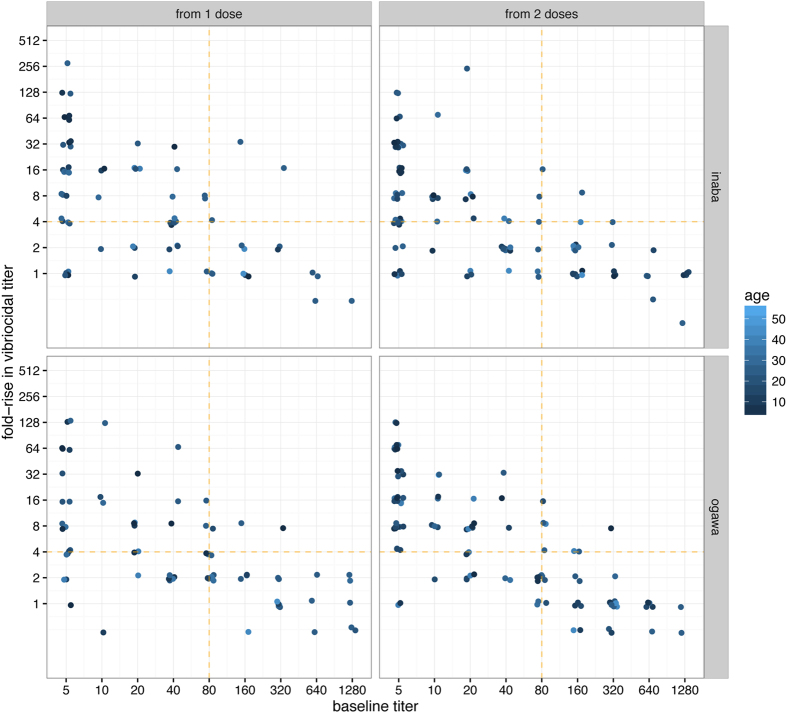
Vibriocidal responses from one and two-doses of OCV by baseline titer (x-axis), age (color) and serotype (rows).Horizontal dashed orange line represents 4 fold rise threshold; Vertical dashed line marks baseline titer 80.